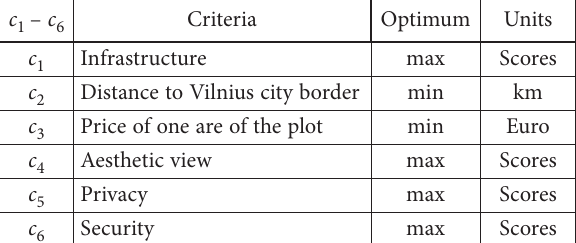
Table 2. Sorting criteria by relevance